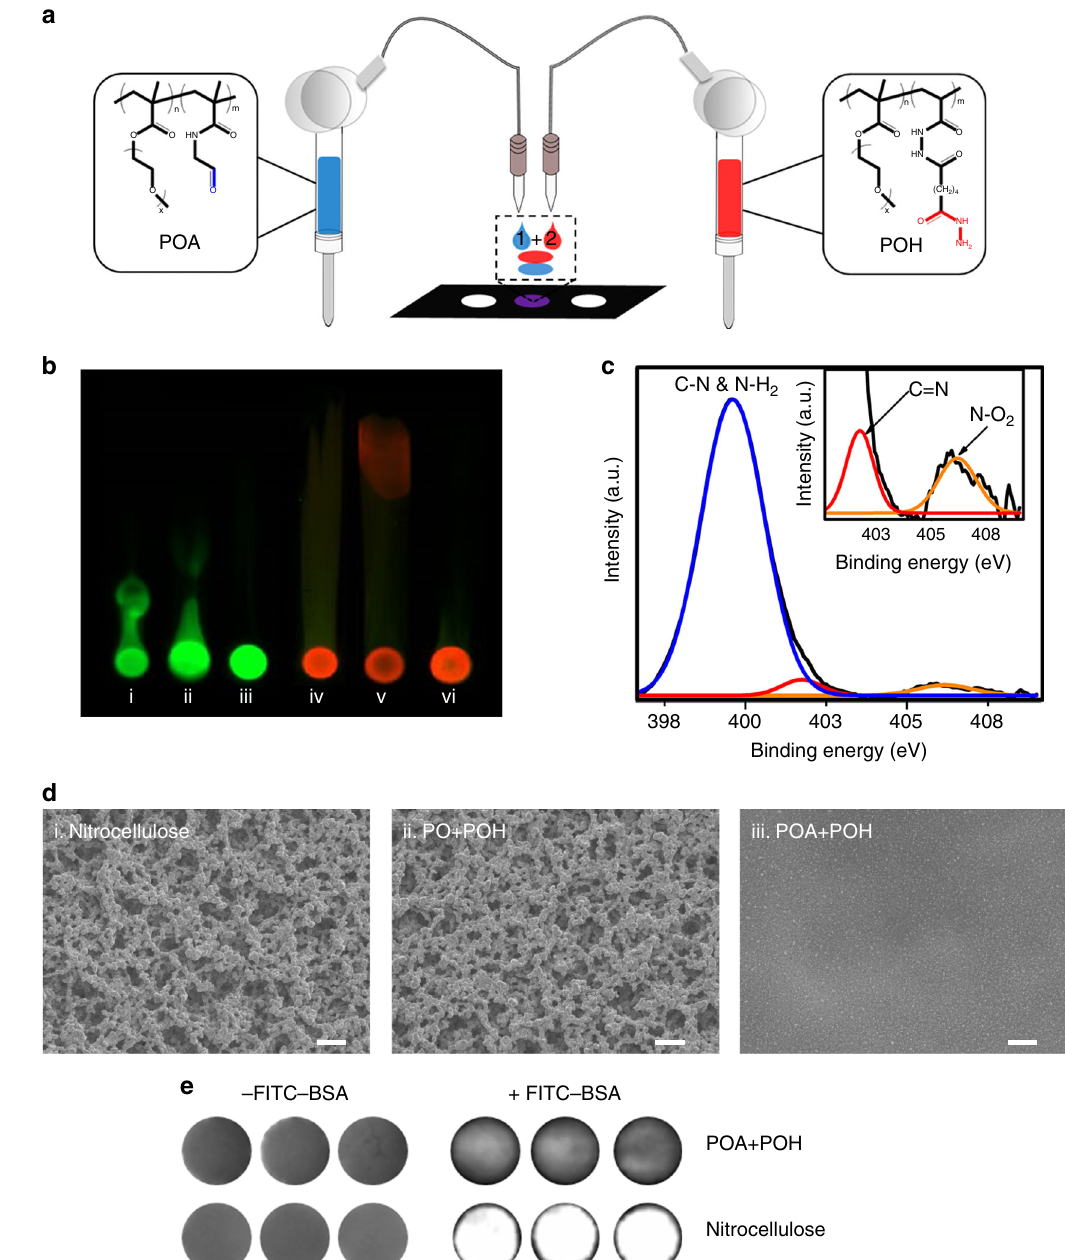
Fig. 1 Thin layer hydrogels can be printed on nitrocellulose. a Schematic of aldehyde-functionalized poly(oligoethylene glycol methacrylate) (POA) and hydrazide-functionalized poly(oligoethylene glycol methacrylate) (POH) polymers sequentially printed onto a nitrocellulose paper substrate using a solenoid-controlled drop-on-demand printing system. b Chromatographic separation of printed polymers on nitrocellulose strips in 70:30 methanol: water: (i) fl uorescein isothiocyanate-labeled hydrazide-functionalized poly(oligoethylene glycol methacrylate) (FITC-POH) alone; (ii) FITC-POH printed on top of unfunctionalized poly(oligoethylene glycol methacrylate) (PO) (PO+FITC-POH); (iii) FITC-POH printed on top of aldehyde-functionalized poly (oligoethylene glycol methacrylate) (POA) (POA+FITC-POH); (iv) Rhodamine-labeled aldehyde-functionalized poly(oligoethylene glycol methacrylate) (Rhodamine-POA) alone; (v) Rhodamine-POA printed on top of PO (PO+Rhodamine-POA); (vi) Rhodamine-POA printed on top of POH (POH +Rhodamine-POA). c High-resolution XPS spectra of printed hydrogel (POA + POH) on a nitrocellulose substrate collected in the N 1 s region. The peak at 401.7 eV corresponds to the – C = N group characteristic of a hydrazone bond, con fi rming gel formation. d SEM images of (i) bare nitrocellulose, (ii) an uncrosslinked polymer assembly (PO+POH) printed on nitrocellulose, and (iii) a printed hydrogel (POA+POH) on nitrocellulose following vigorous washing of the samples in 10 mM PBS. Scale bars, 10 µ M. e Fluorescence scans of bare nitrocellulose and printed hydrogel (POA+POH) samples before and after incubation in 100 μ g ml − 1 FITC-BSA show a signi fi cant reduction in nonspeci fi c protein adsorption following the printing of the hydrogel on the